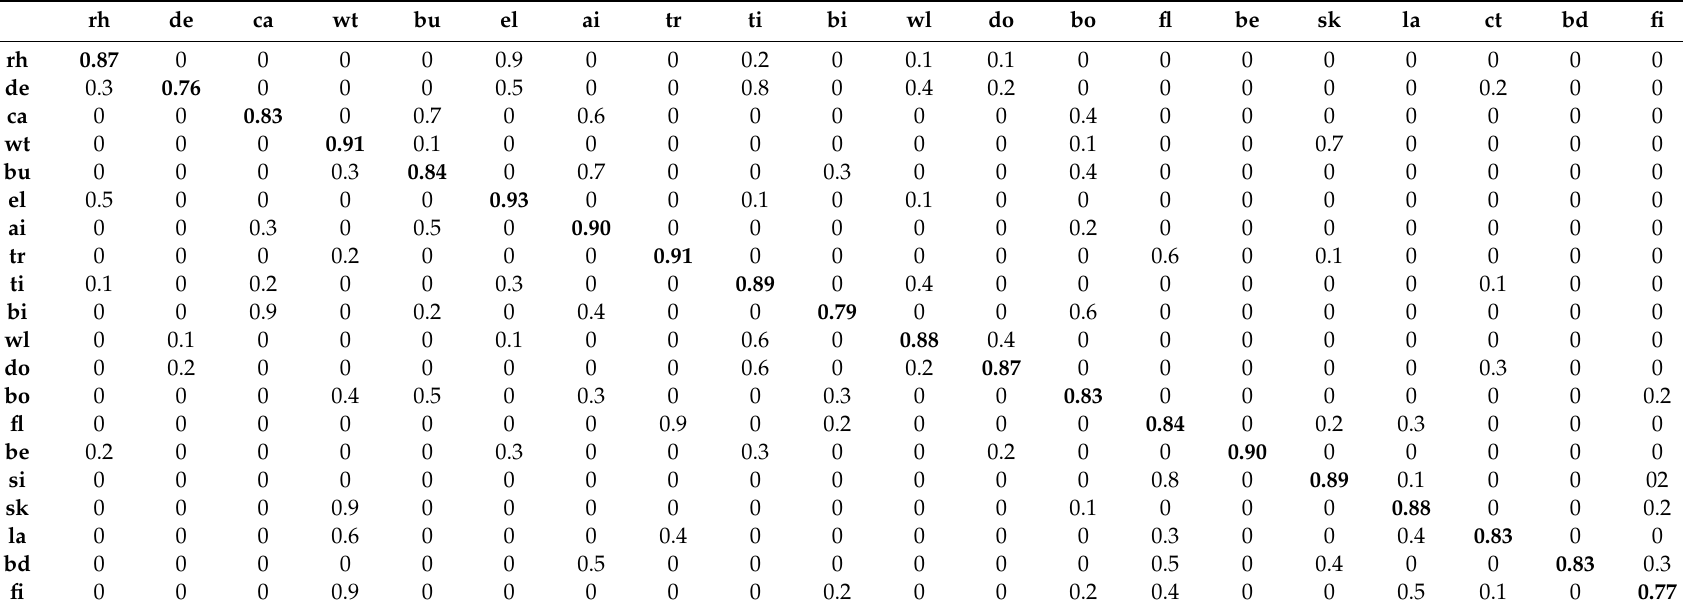
Table 6. Confusion matrix of accuracy for object classification of outdoor scenes for the proposed approach using the Corel-10k dataset.